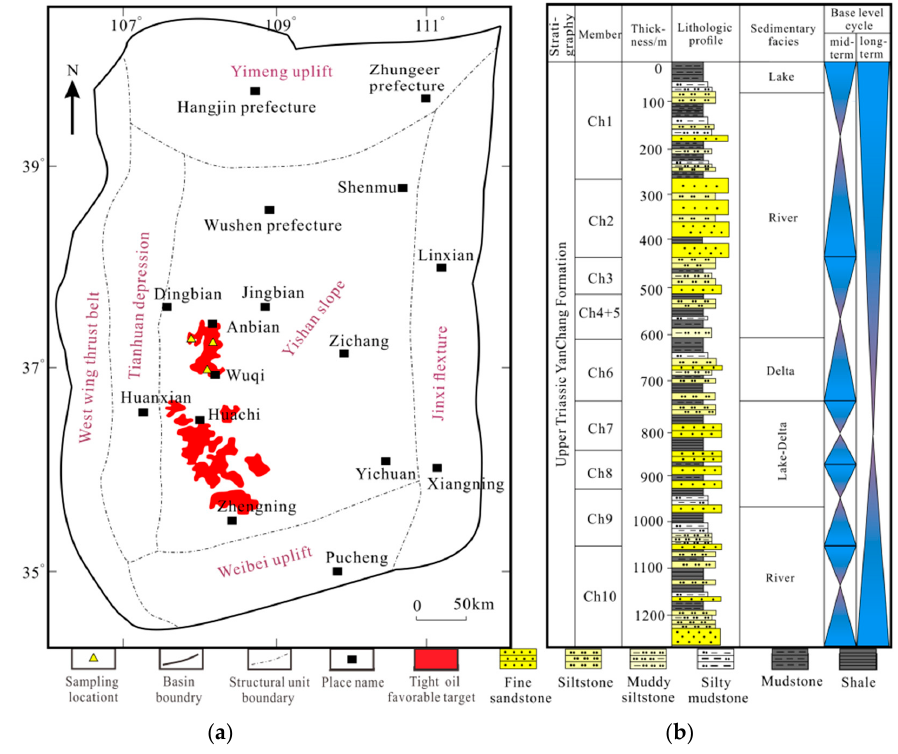
Figure 1. ( a ) Tectonic divisions and tight oil favorable target of Ordos basin, and ( b ) Stratigraphic column of the Yanchang Formation (Revised from Wang et al. and Liu et al. [23,24]).